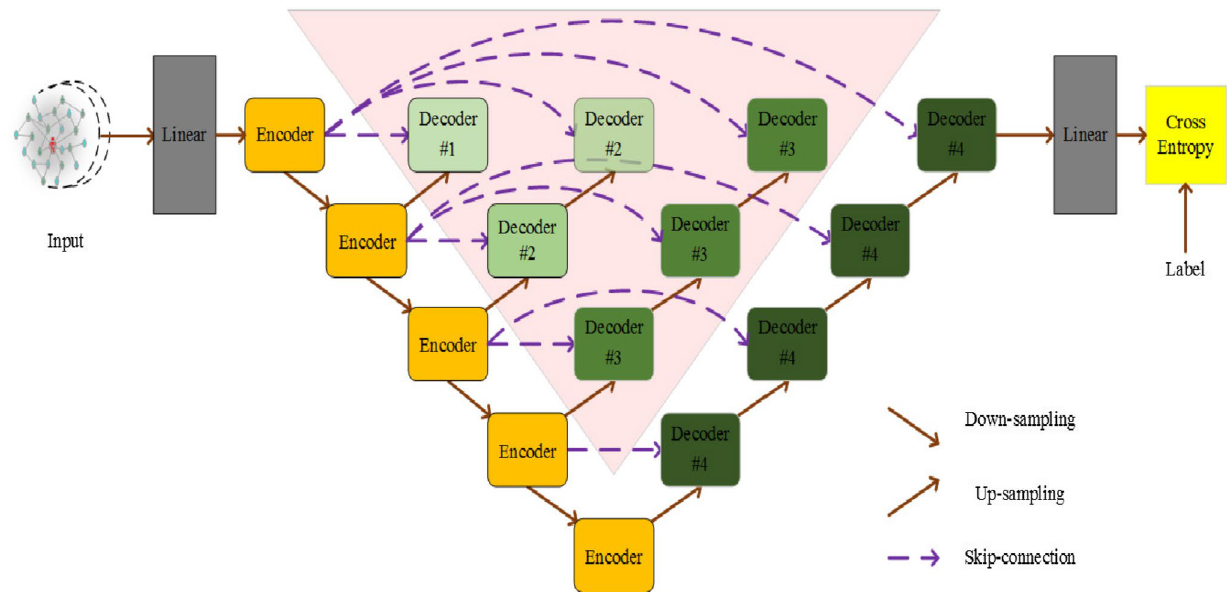
Fig. 3 We compress the four graph U-Nets of different depths that maintain the original skip-connection way together, and find that the red region cannot be trained through back